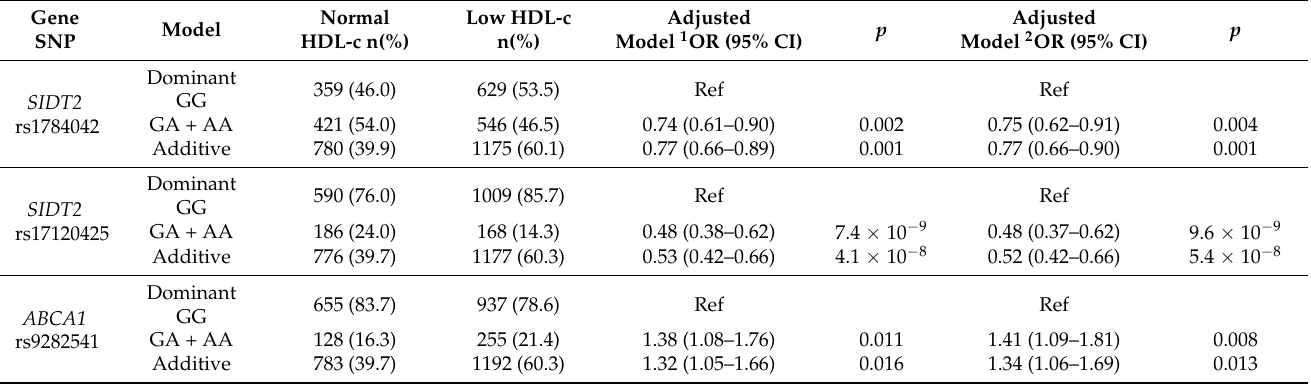
Table 3. Association between rs1784042, rs17120425, and rs9282541 variants and low